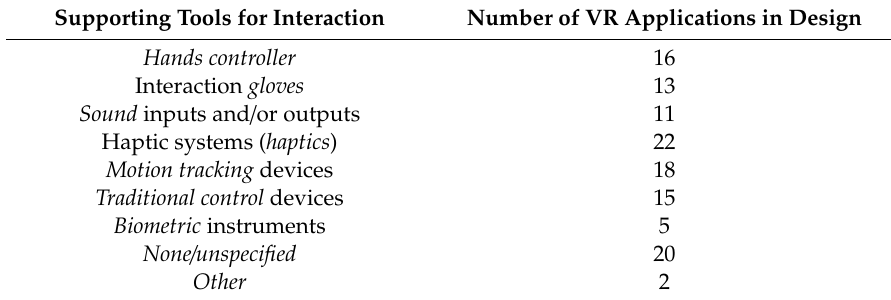
Table 7. Number of design applications in which VR supporting tools were relevant for the specific case study.